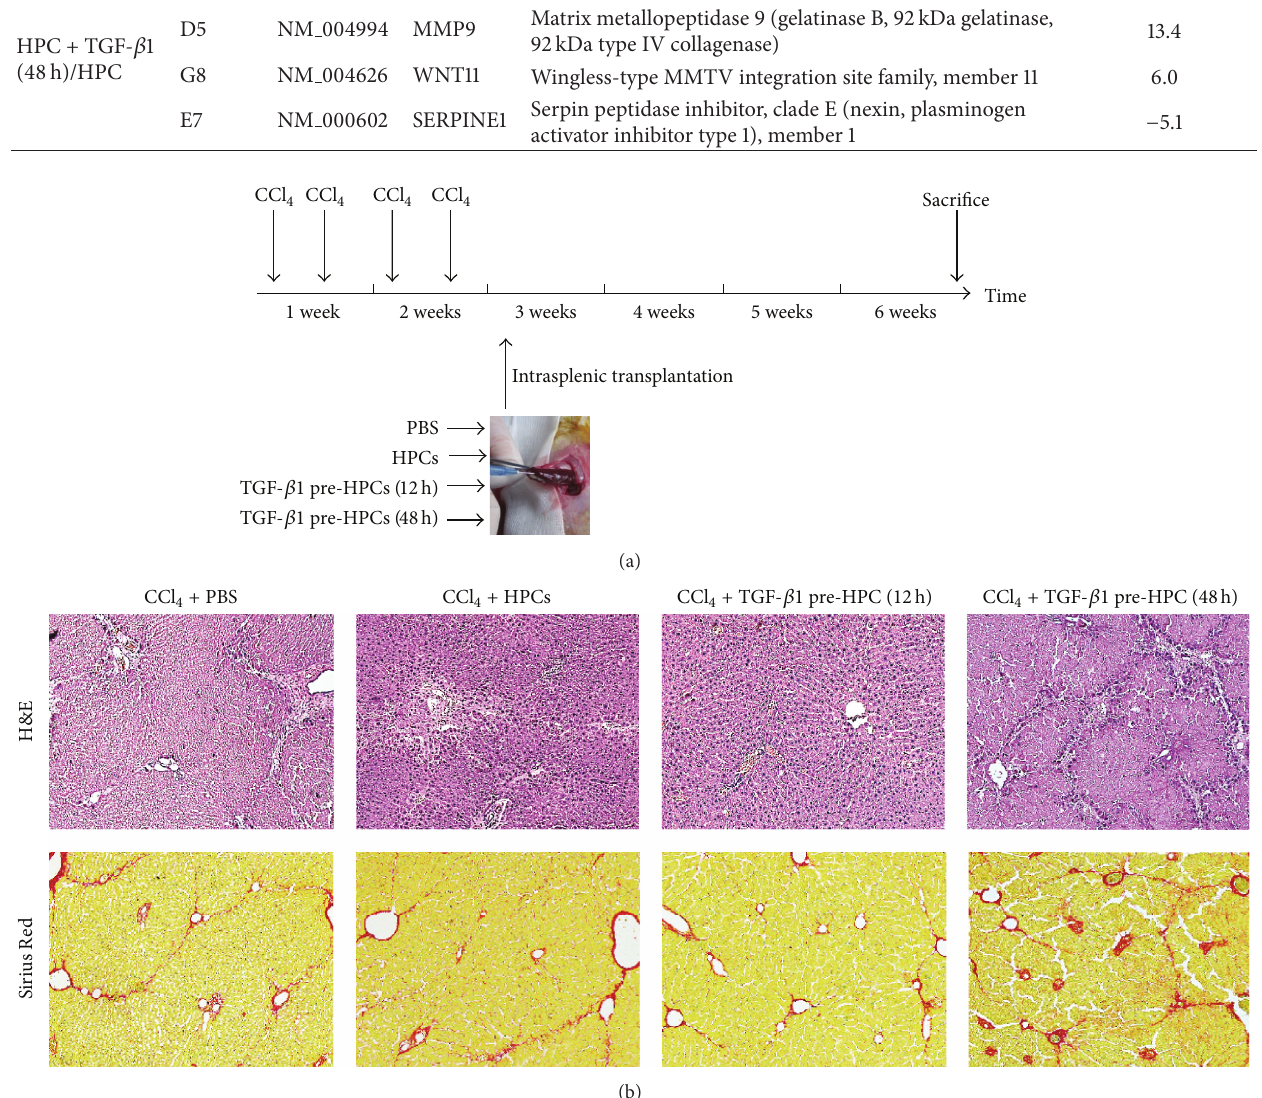
Figure 4: Therapeutic effects of transplanted HPCs, HPCs pretreated with TGF- 𝛽 1 for 12h, and HPCs pretreated with TGF- 𝛽 1 for 48 h on recovery in the rat model with CCl 4 -induced injury. Schematic description of the experiment (a). Hepatic collagen deposition was determined by H&E and Sirius Red staining